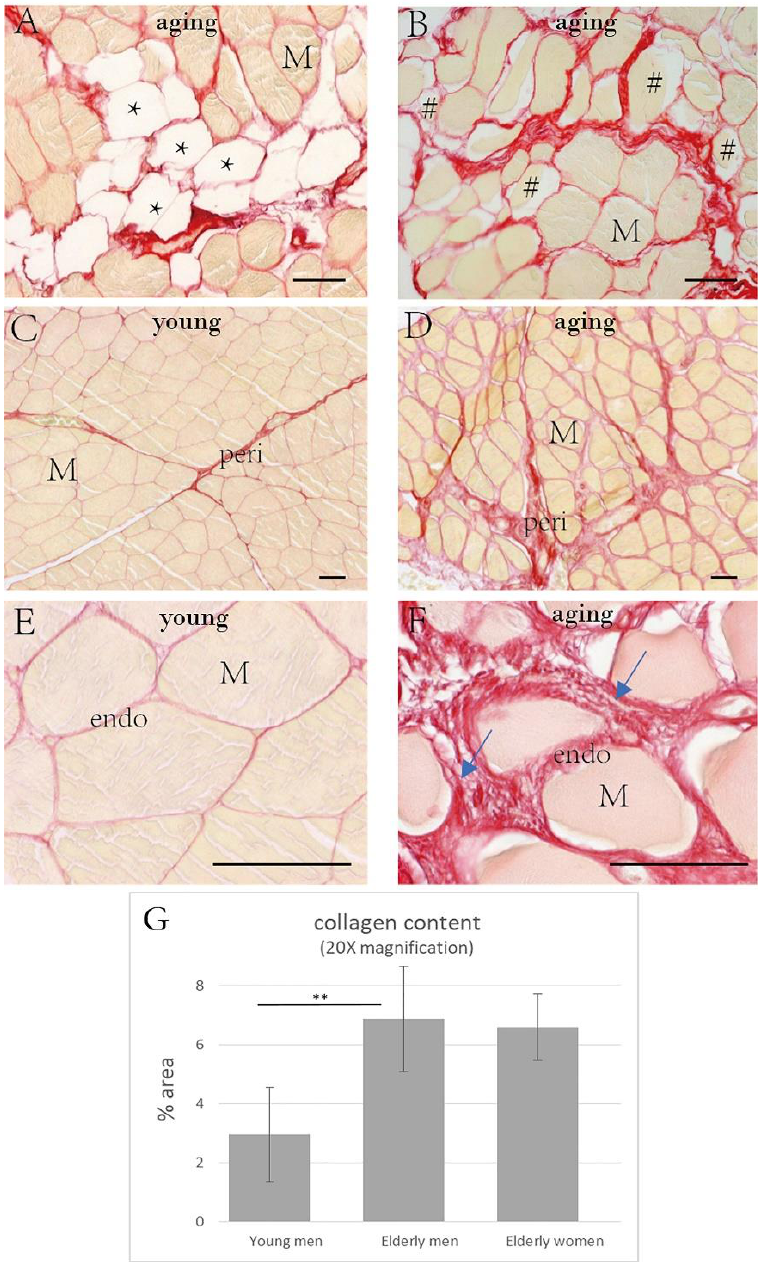
Figure 1. Picrosirius red staining in the human muscle samples. ( A ): muscle sample from an 87 year old man with fat infiltration (*); ( B ): muscle sample from a 94 year old woman with muscle atrophy ( # ). The collagen intensity and the disposition of the fibers stained (in red) are shown in young subjects (( C ), 18 year old male; ( E ), 32 year old male) and in elderly men (( D ), 83 years old; ( F ), 94 year old male). The altered arrangement of the collagen fibers can be noted in the older subject (arrows). The analysis of the collagen content ( G ) showed the higher amount of collagen in elderly men with respect to young men (** p < 0.01). M = muscle cell, peri: perimysium, endo: endomysium. Scale bar: 50 µ